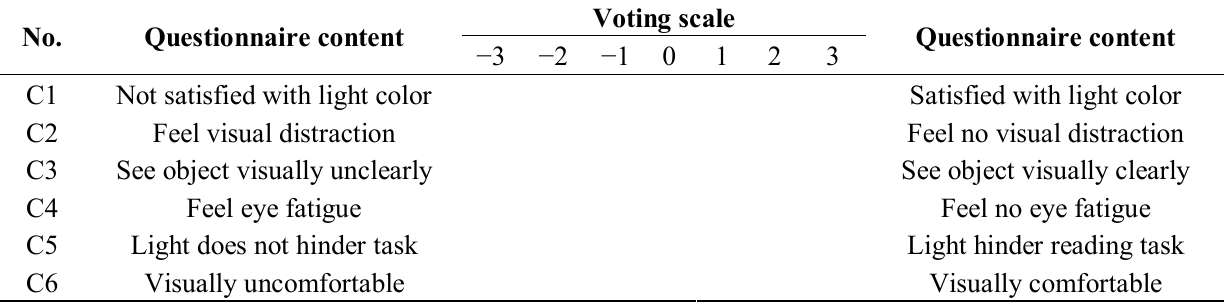
Table 2. Survey questionnaires for visual annoyance and comfort.